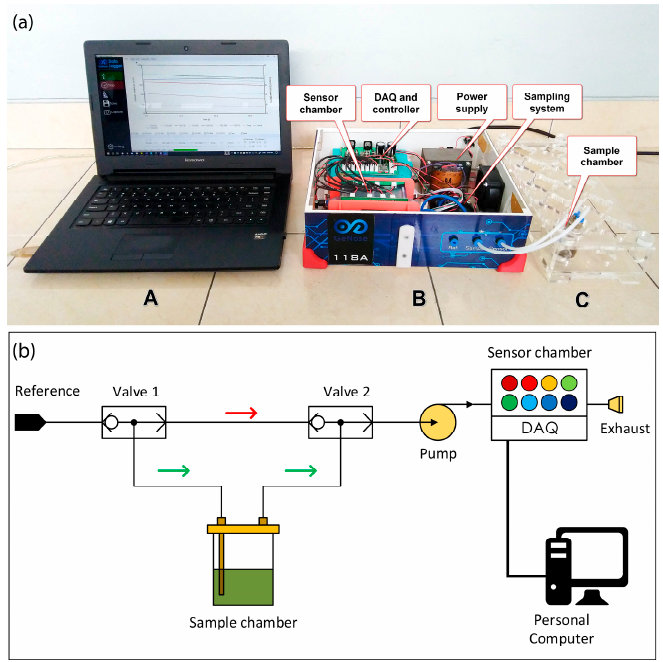
Figure 1. ( a ) Photograph the E-nose device used in this study (A: computer with chemometric tools, B: main part of the E-nose devices, and C: chamber of sample); ( b ) Schematic diagram of the E-nose device (DAQ: data acquisition system).